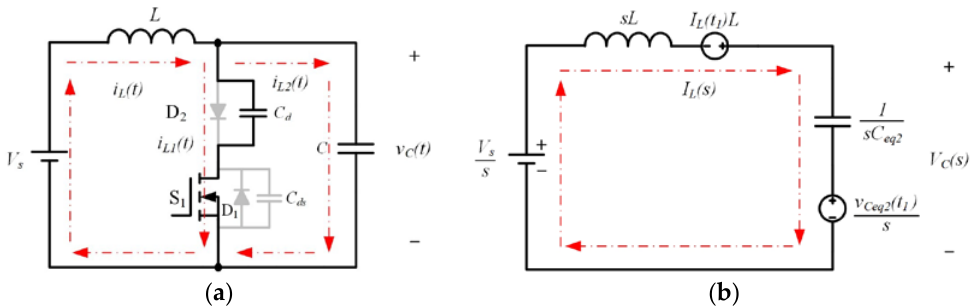
Figure 5. Mode 2 principle: ( a ) the equivalent circuit; ( b ) the Laplace transform circuit.